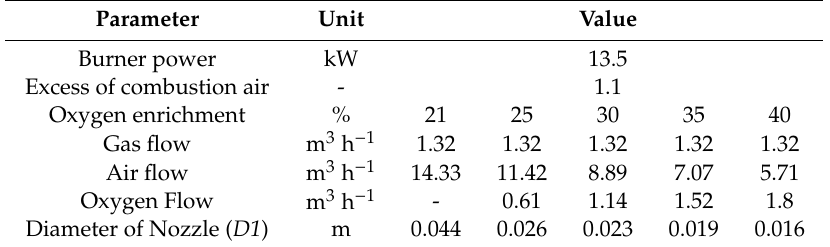
Table 1. Volume flows of the inlet media depending on the oxygen concentration in the oxidiser. Parameter Unit